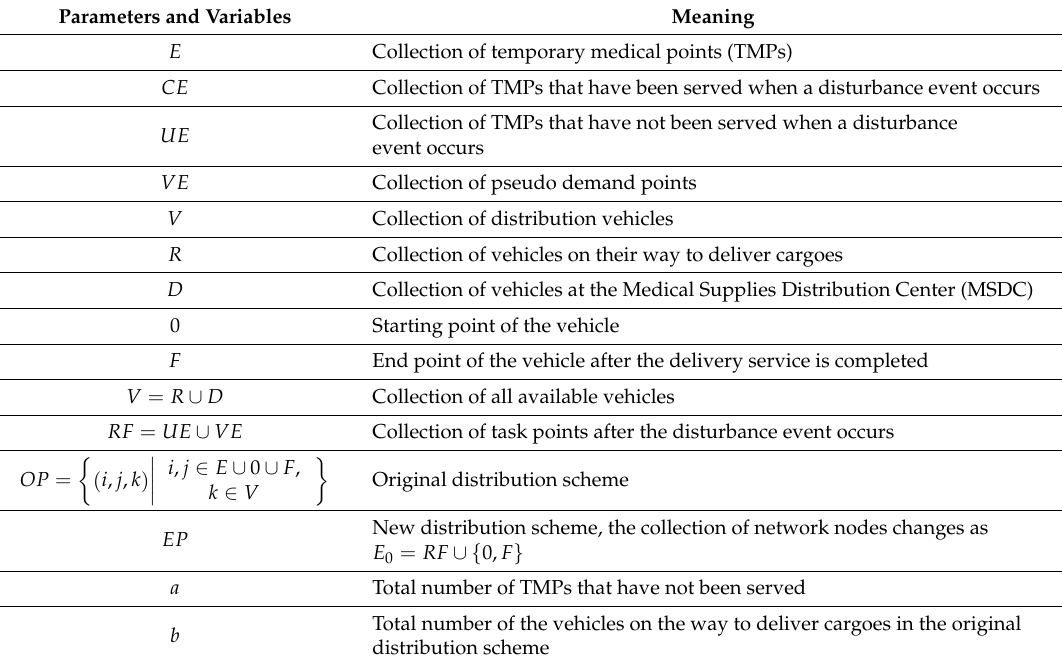
Table 1. The meanings of parameters and